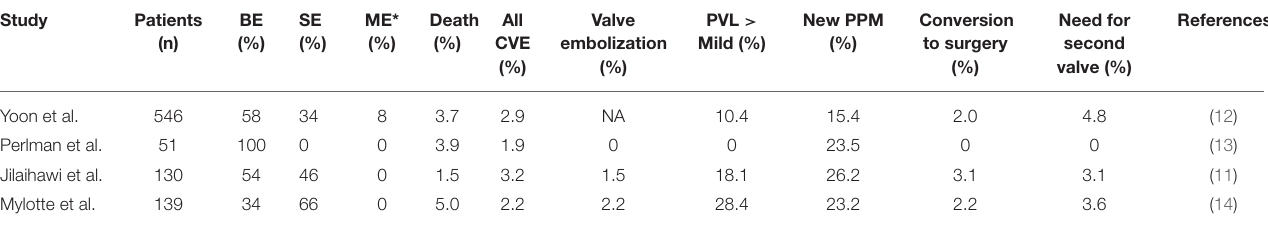
TABLE 1 | Summary of 30-day outcomes in the main TAVI trials in patients with bicuspid aortic stenosis. Study Patients (n)